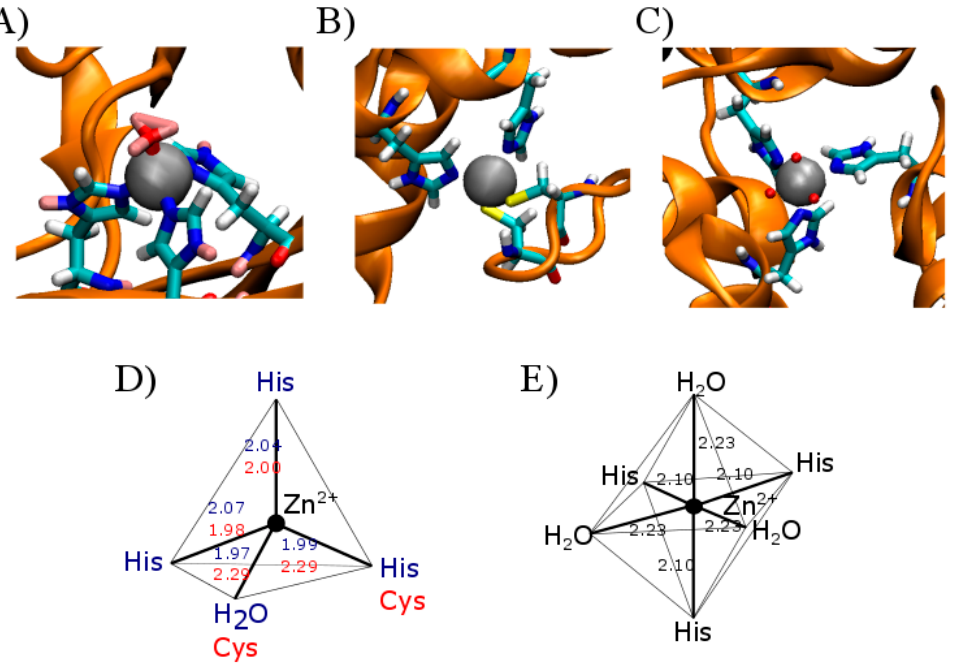
Figure 1. Representative examples of zinc-containing proteins and the representation of their corresponding metal coordination geometries. The illustration shows a representation of the zinc binding pockets of two classic metalloproteins. ( A ) shows the zinc binding motif in carbonic anhydrase II (PDB: 3KKX) and its corresponding coordination sphere ( D ) in blue, including the length of the coordination bonds in angstroms; ( B ) represents a zinc finger motif present in the human enhancer binding protein MBP-1 (PDB:1BBO) with its corresponding coordination sphere ( D ) in red, including binding lengths; ( C ) represents hexameric human insulin (PDB: 1MCO) with its Zn coordinating sphere ( E ) and the corresponding atom binding lengths. The light blue ball in ( A – C ) represents the zinc atom; dark blue represents the imidazole nitrogen involved in the coordination sphere, while red represents the oxygen, and yellow the sulfur atoms interacting with zinc. The interactions are shown by the dashed line in light blue. In ( D , E ) the atomic distances between zinc and its coordination sphere are indicated in angstroms. Blue numbers in ( D ) apply to ( A ), red in ( D ) apply to ( B ) and black in ( E ) correspond to ( C ) as detailed. 1.3. Zinc Coordination in Proteins: Residues Involved in Structural versus Catalytic sites The dominant view until the 1970s assumed that Zn(II) coordinates with proteins,